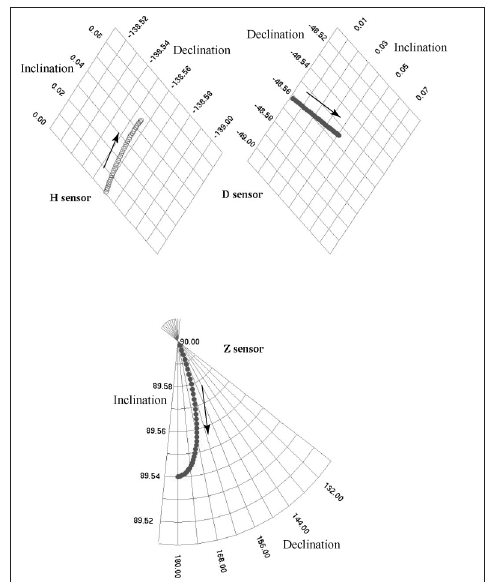
Fig. 6. Drift of the vector magnetometer sensors over the time span 2005-2007. H is nearly horizontal, close to the magnetic North direction; D is nearly horizontal, close to the magnetic East direction; Z is close to vertical. The time step is one month; the an- gles are expressed in degrees and minutes. Full cir- cles: positive inclinations; open circles: negative in- clinations.